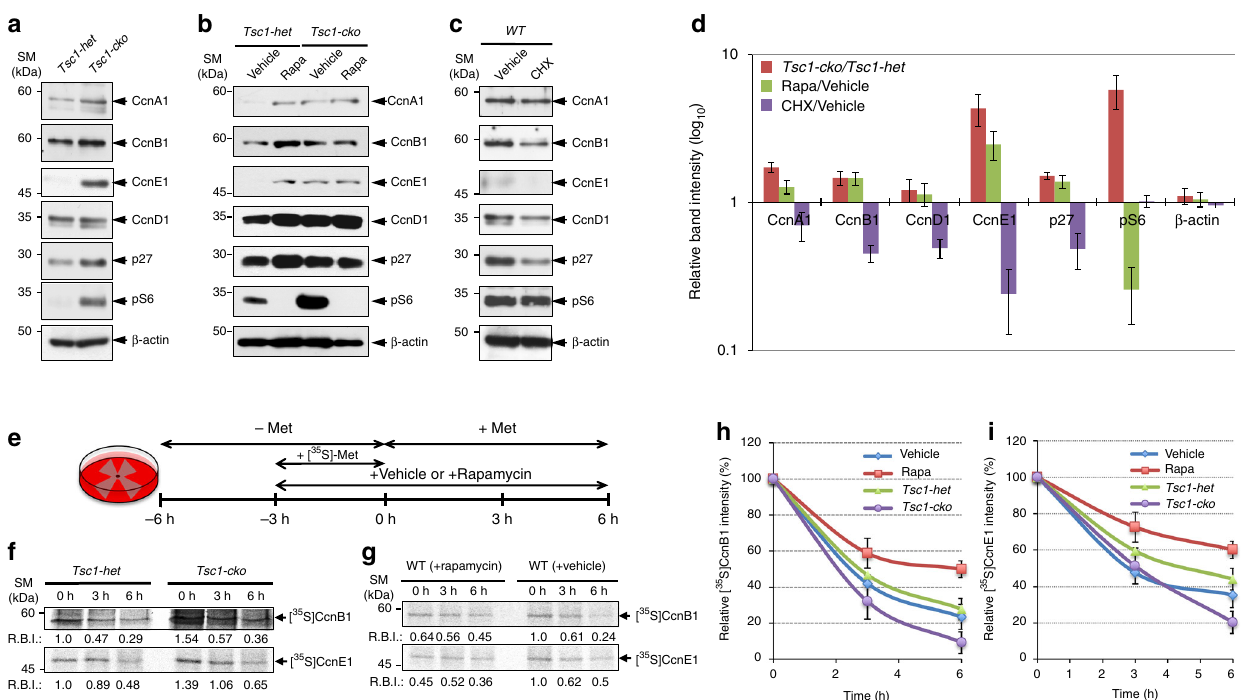
Fig. 5 Cyclin turnover in RPC is sensitive to mTORC1 activity. a Proteins (20 μ g) of cell lysates of E14.5 Tsc1-het and Tsc1-cko littermate mouse retinas were analyzed by WB with corresponding antibodies. Alternatively, pregnant mice can produce either Tsc1-het or Tsc1-cko mice were injected with vehicles (control in b and c ), rapamycin (5 mg/kg; b ), or cycloheximide (CHX; 5 mg/kg; c ) at 14 dpc prior to collecting the embryonic retina at 14.5 dpc for WB analyses. d Image pixels of WB bands were calculated by the ImageJ software and relative intensities were obtained by comparing the pixel numbers with those of control samples ( Tsc1-het retina for Tsc1-cko ; vehicle-injected retinas for rapamycin and CHX). Values are average measurements of 3 independent WB results. Error bars denote SD. e Experimental schedule for labeling and chasing of newly synthesized cyclin proteins in mouse retinal explants. E13.5 littermate retinal explants were incubated in methionine (Met)-free growth media for 3 h and then added with [ 35 S]-Met (250 μ Ci/ml) for 3 h to label newly synthesized proteins in the retinas. The explants were then incubated in normal growth media containing unlabeled Met for the indicated time. For the analysis in g , WT C57BL6/J mouse retinal explants were added with growth media containing vehicle or rapamycin as indicated. f , g CcnB1 and